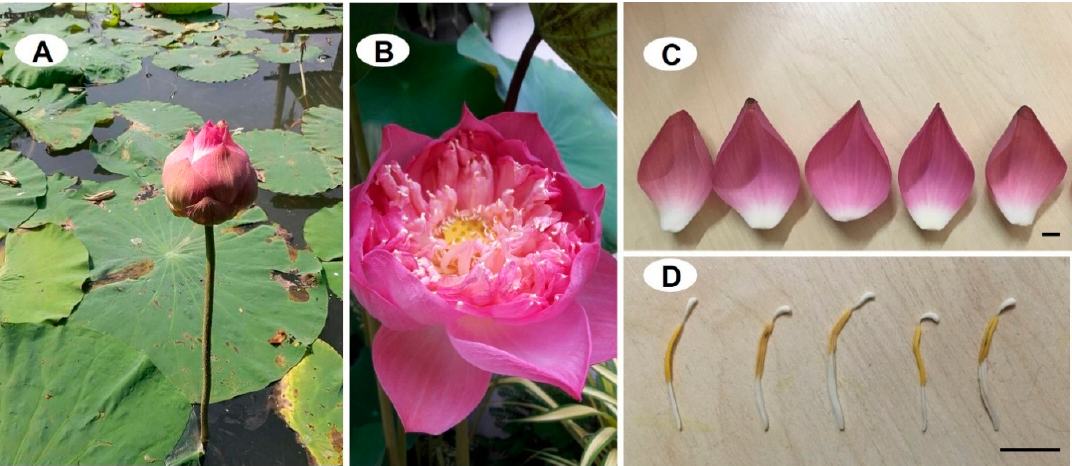
Figure 1. Nelumbo nucifera Gaertn.: ( A ) natural habitat; ( B ) flower; ( C ) perianth; and ( D ) dtamen. The photos were taken by D.T. Bar scale = 1 cm.